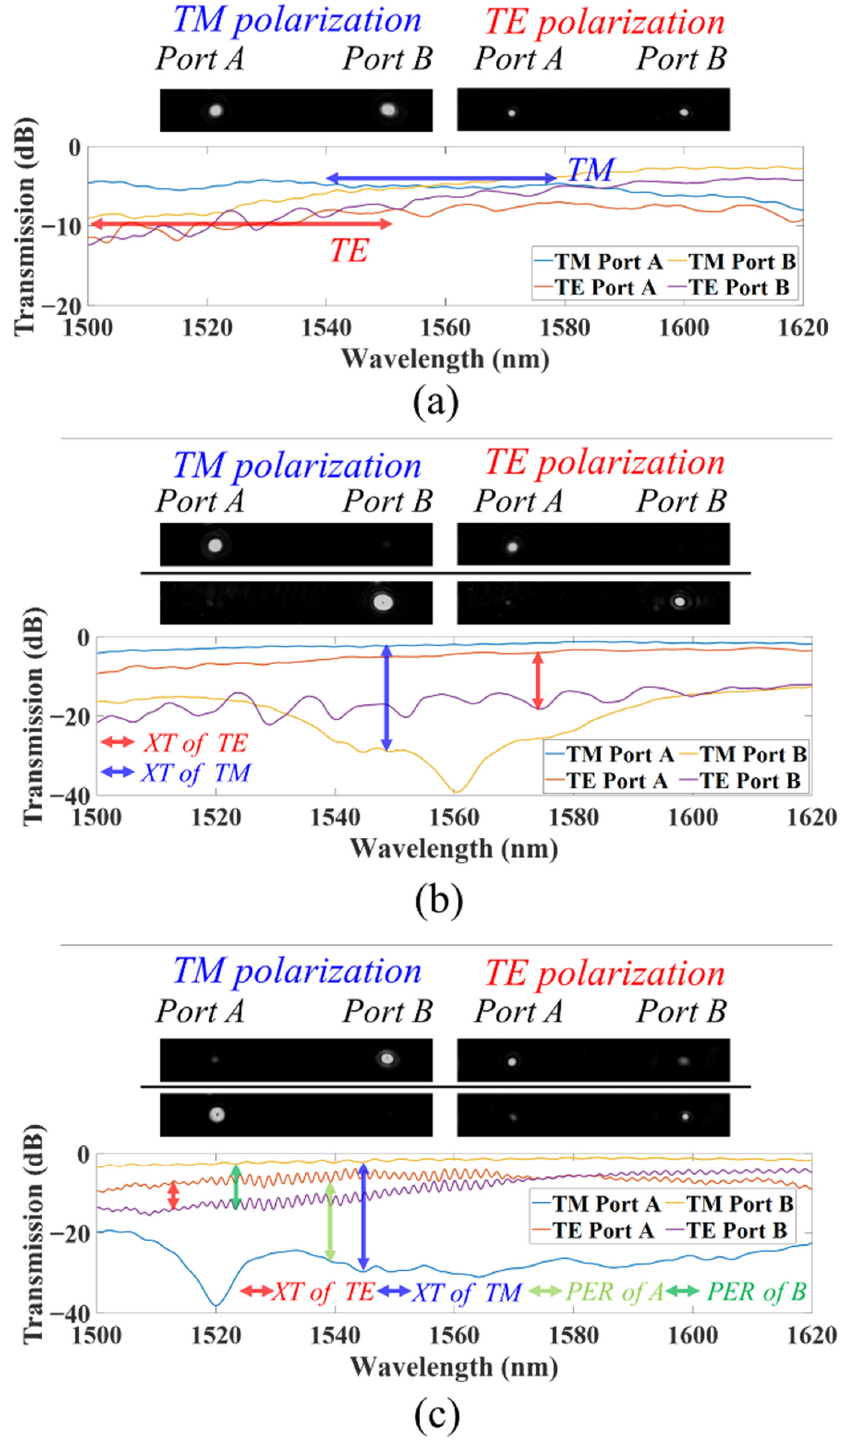
Figure 4. End-facet near-field images at 1550 nm and fiber-chip-fiber transmission spectra for different functions ( a ) I-BS, ( b ) II-PS, and ( c ) III-PBS. XT: Crosstalk, PER: Polarization extinction ratio.